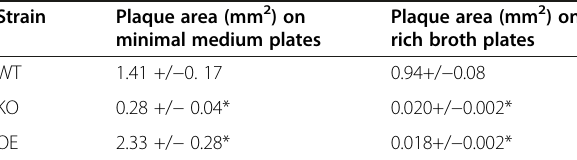
Table 1 Comparison of plaque size on rich broth and minimal media